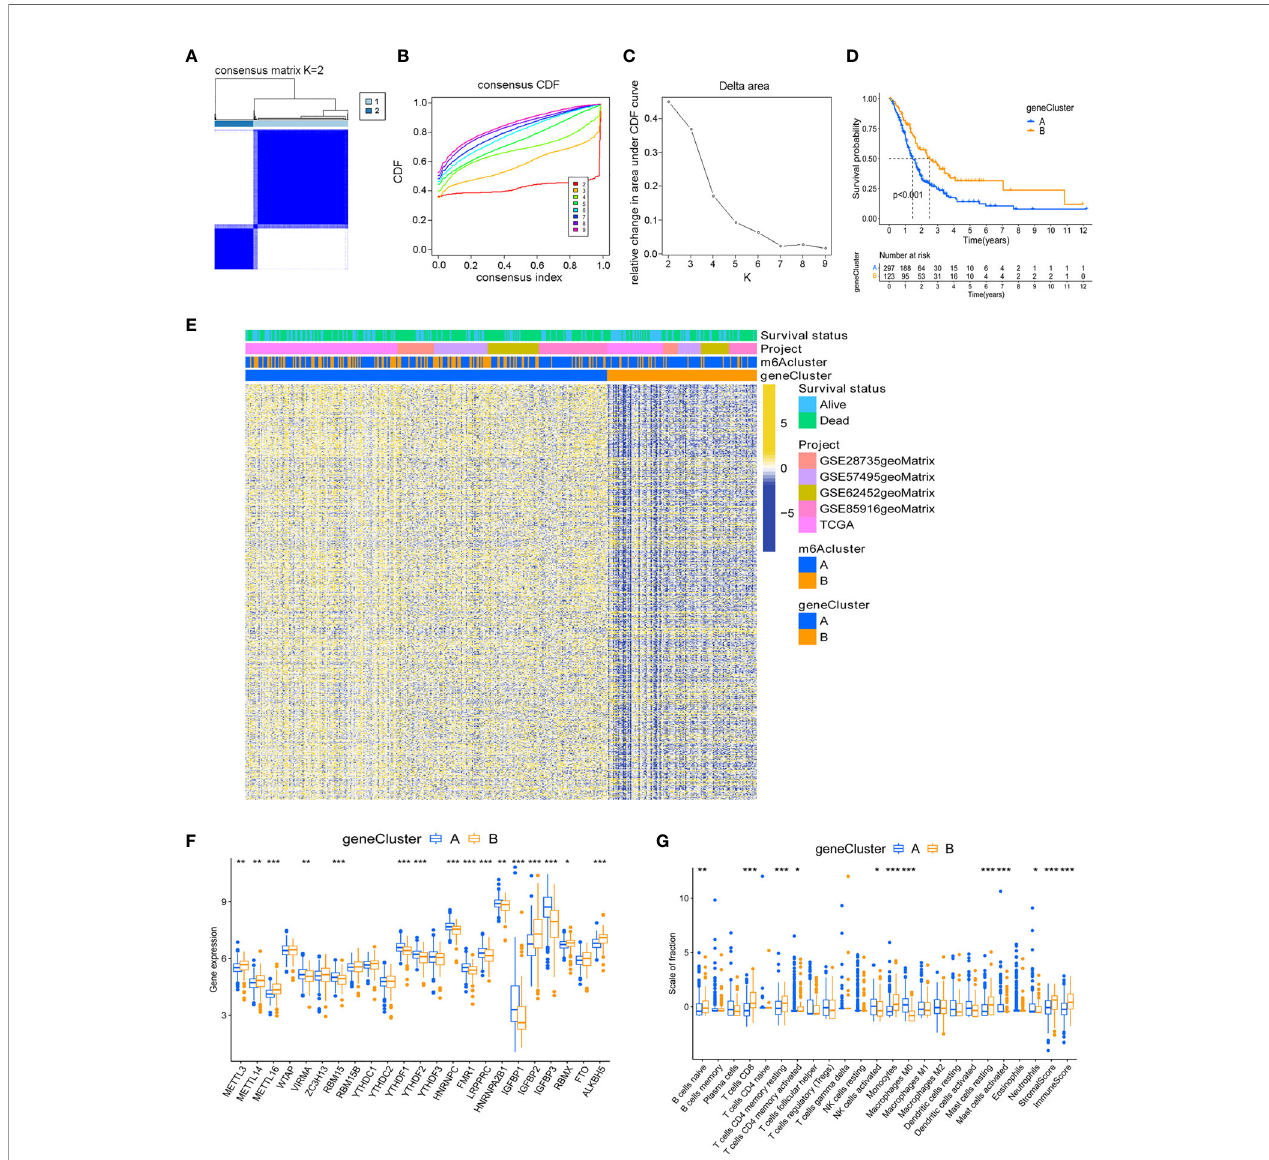
FIGURE 3 | Identi fi cation of m 6 A-relatedgene subtypes. (A) Heat mapofsampleclusteringunder k = 2 in5 independent PC cohorts. (B) Consensus clustering cumulative distribution function (CDF) with the number ofsubtypes k = 2 to 9. (C) The relative change of the area under the CDF curveof k = 2 to 9. (D) Survival analysis of patients in two m 6 A-related gene clusters. (E) Unsupervised clusteringof m 6 A related signature genes. (F) Differences inthe expression of 23 m 6 A regulators between distinct gene clusters. (G) TME immune-in fi ltrating characteristics and transcriptome traits of two m 6 A-related gene clusters. ***P < 0.001; **P < 0.01; *P <